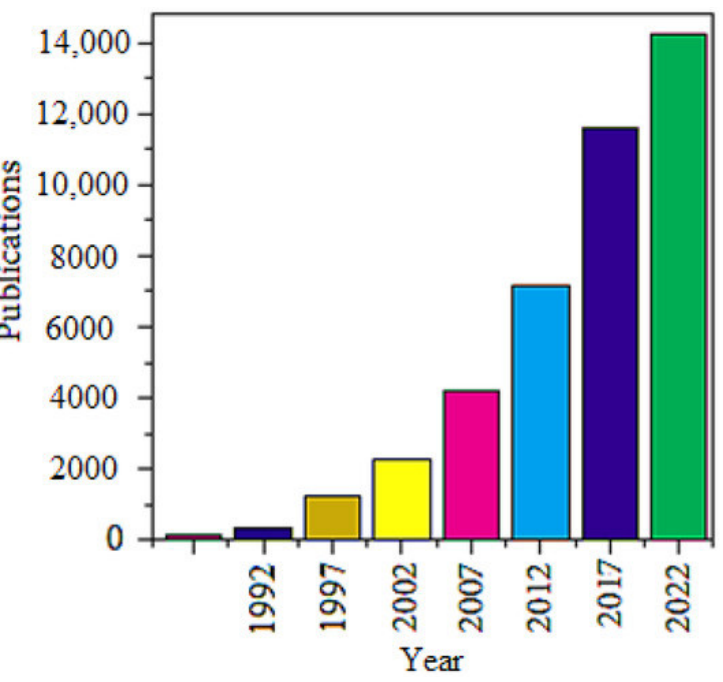
Figure 1. Publication trend of graphene from 1990–2022 Reprinted with permission from Ref. [35]. Copyright 2022, MDPI.